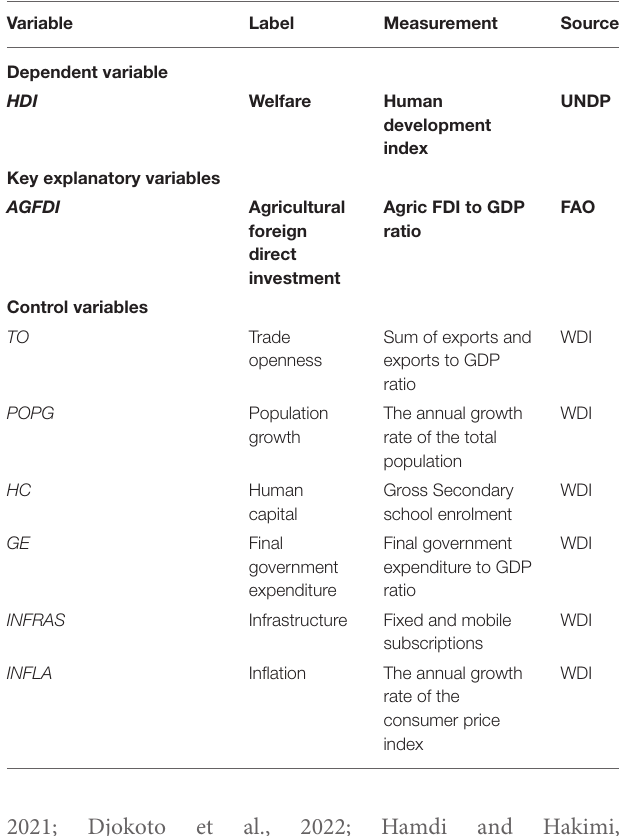
TABLE 1 | Variables, labels, and